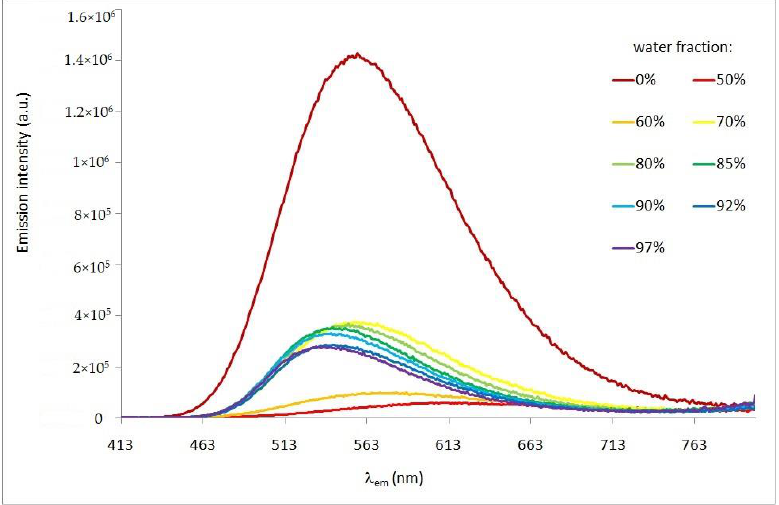
Figure 3. Emission spectra of compound 1 in THF/water mixture ( c = 1.5 × 10 − 5 M, λ exc = 403 nm).